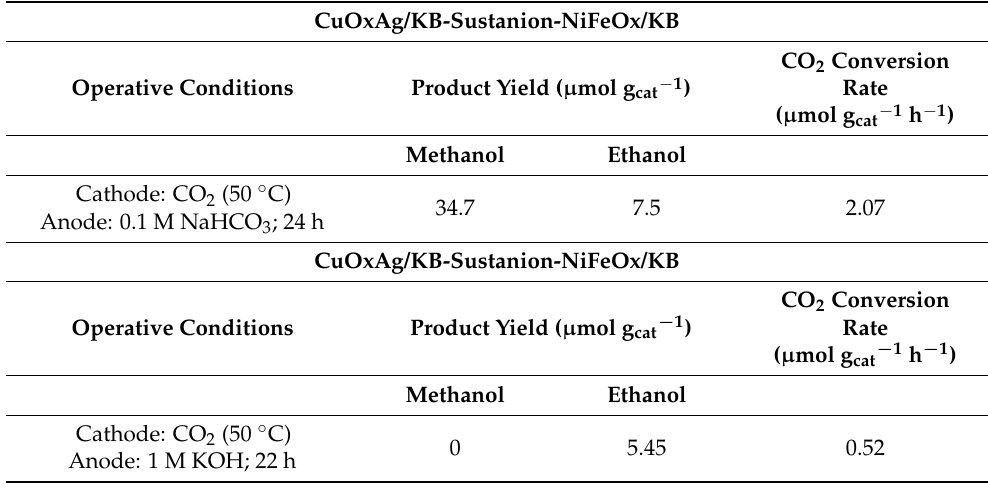
Table 2. Liquid-phase analysis for cell based on CuOxAg/KB-Sustainion